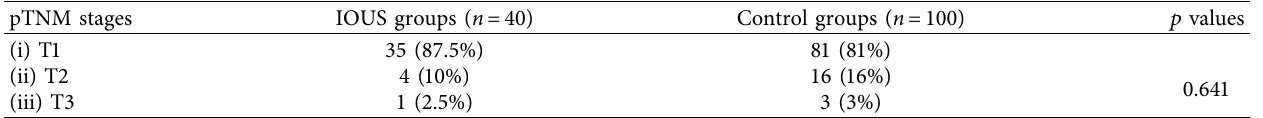
Table 3: Tumor pathological stage in the two study groups.